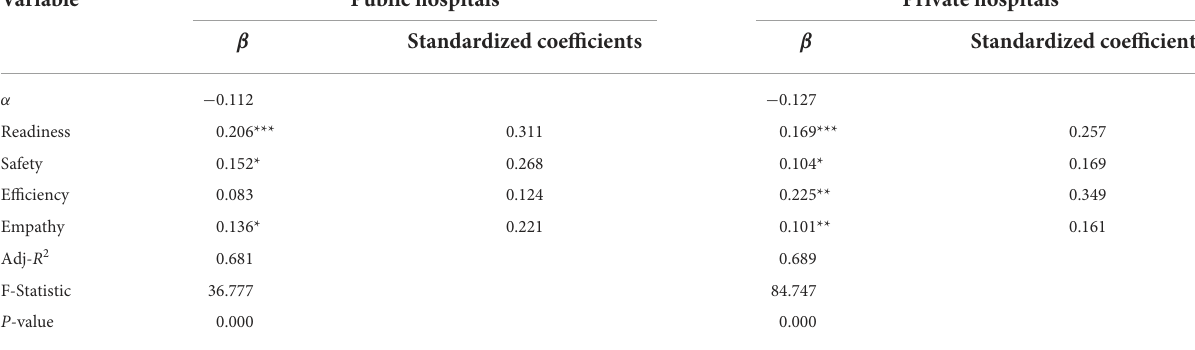
TABLE 5 The Regression of improvement on independent